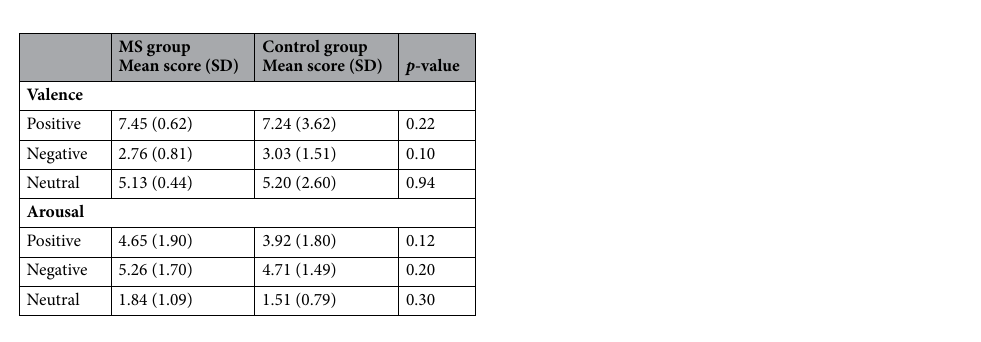
Table 2. Subjective evaluation of positive, negative, or neutral IAPS pictures: comparison of MS group and control group scores for valence and